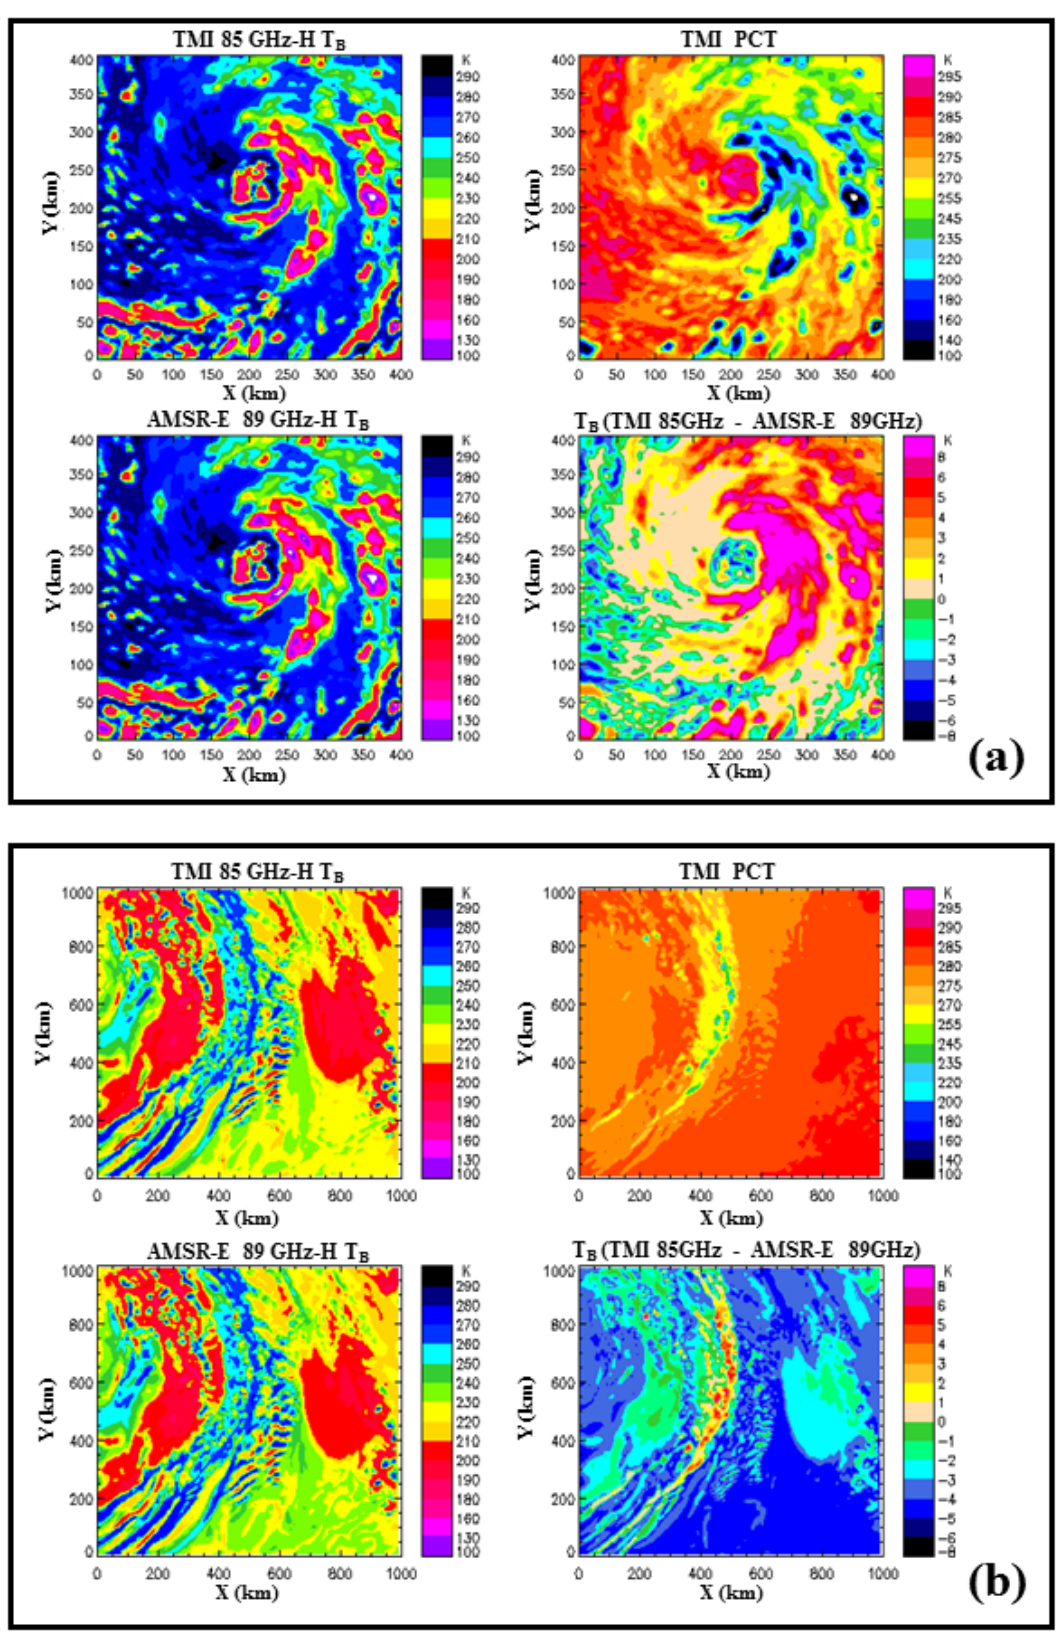
Figure 4. Horizontal distributions of the simulated TMI 85 GHz-H pol (top-left), AMSR-E 89 GHz-H pol (bottom left), TMI 85 GHz PCT (top right) and their T (bottom-right) for ( a ) hurricane Bonnie; and ( b ) squall